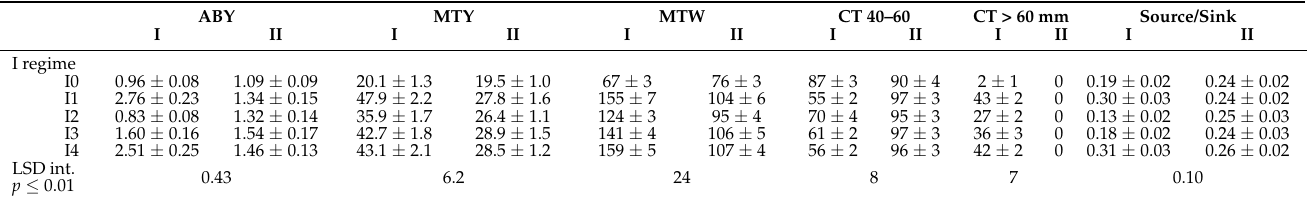
Table 7. Above-ground Biomass Yield (ABY, t DW ha − 1 ), Marketable tuber yield (MTY, t FW ha − 1 ), Mean Tuber Weight (MTW, g), caliber tubers (CT, %) and source/sink ratio as affected by interaction “irrigation regime ×